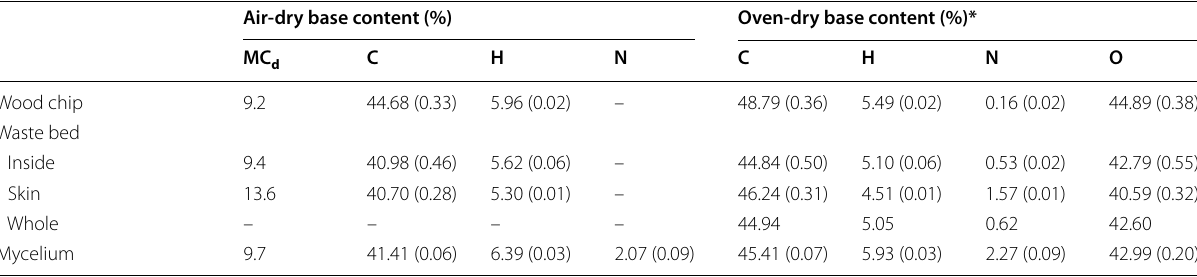
Table 3 Results of the elemental analysis